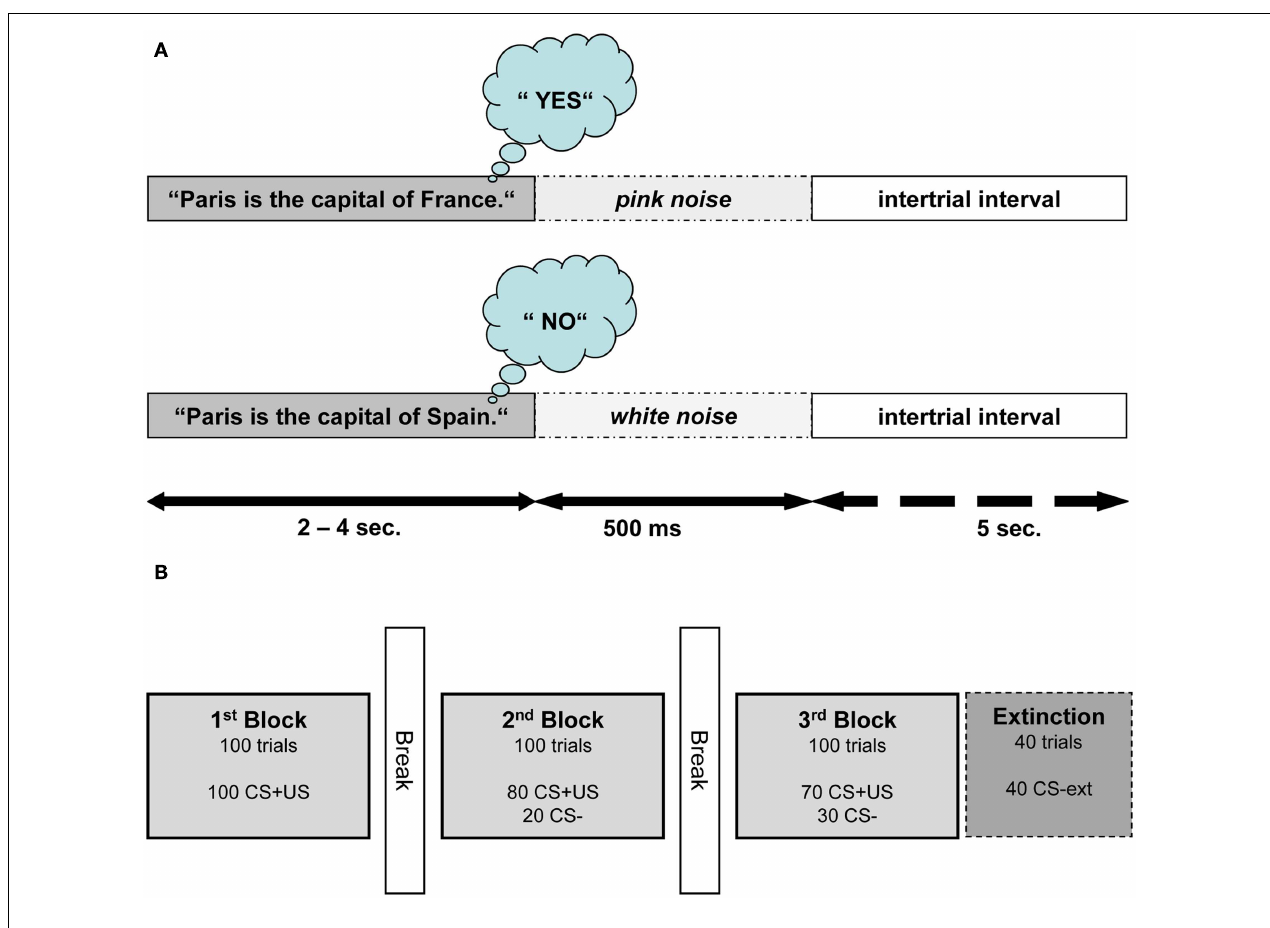
sentence is presented; nevertheless all sentences were presented in German. (B) Illustrates the experimental procedure of one session.The extinction block was introduced only in the second